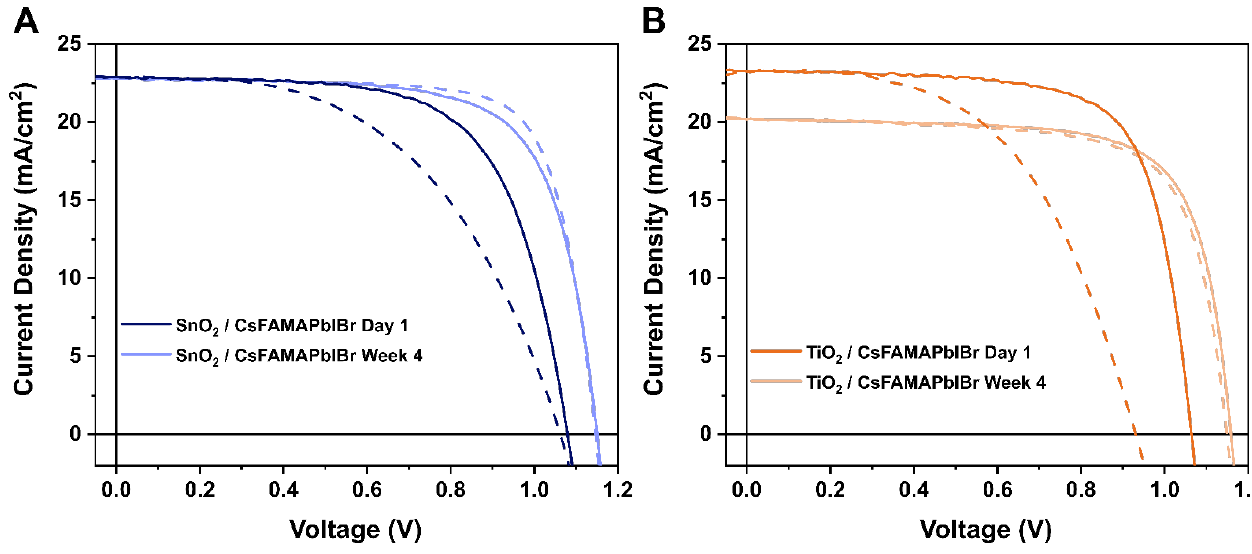
Figure 1. JV curves measured at 1 Sun conditions (100 mW/cm 2 , AM 1.5 G) in forward (dashed line) and reverse (solid line) scan for CsFAMAPbIBr on SnO 2 ( A ) and TiO 2 ( B ) in fresh and aged devices.